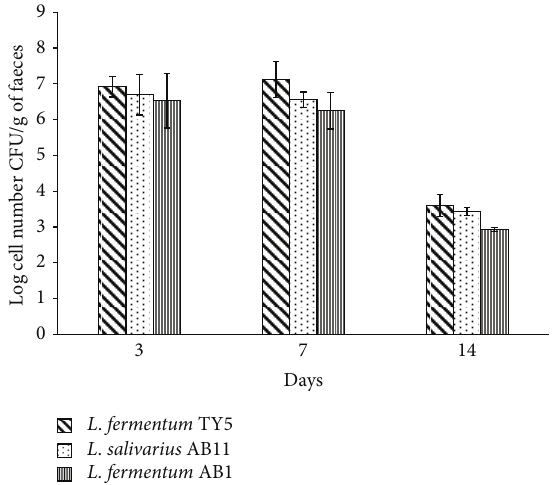
Figure 4: Recovery of Rif R strains from rat faecal samples on days 3, 7, and 14. The data is represented as mean value of log CFU/g faeces. Rif R strains were recovered on days 3 and 7 and decreased on washout